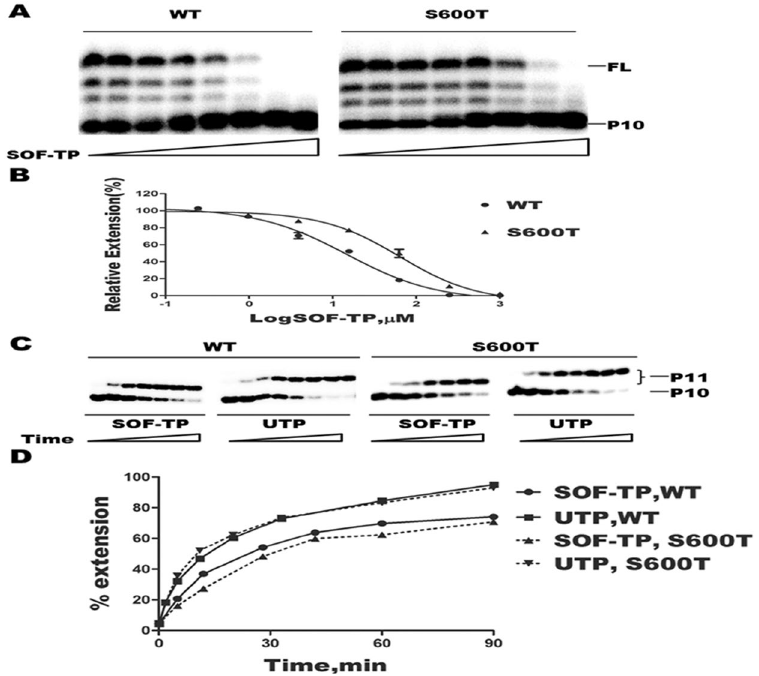
Figure 4. Inhibition of DENV NS5 RdRp activity by SOF-TP and time course of incorporation of SOF-TP or UTP in primer extension assays by DENV WT NS5 and the S600T mutant. ( A ) Inhibitory effect was determined by in vitro primer extension assay using purified NS5 protein s and P10/T14 RNA duplex template in RdRp assay buffer in the presence of 0.5 µ M each of NTPs and variable concentrations of SOF-TP. Reaction products were analyzed by denaturing polyacrylamide gel electrophoresis (6% acrylamide, 7 M Urea). P10 and FL indicate the positions of the 5 ′ -end radiolabelled P10 primer and full-length extension products of the primer extension reactions. ( B ) Dose-response curves showing inhibition by SOF-TP of the activity of DENV NS5 WT and the S600T mutant. The IC50 (50% inhibitory concentration) value was defined as the concentration of SOF-TP at which the full-length (FL) products were decreased by 50% relative to the control reaction performed in the absence of SOF-TP, and was calculated by nonlinear regression analysis: IC 50 WT = 14.7 ± 2.5 µ M, IC 50 S600T = 63.8 ± 5.3 µ M. The data represent the means ± standard deviation (SD) of 3 independent experiments. ( C ) The RNA T14 template and 5 ′ -end radiolabeled RNA primer P10 duplex were used to assess the incorporation efficiency of UTP and SOF-TP on RNA synthesis by use of purified recombinant DENV NS5 WT and S600T mutant enzymes in time course primer extension assays over a period of 90 min. Sampling time points for UTP (min): 0.2, 2, 5, 10, 20, 30, 60, 90; SOF-TP (min): 0.2, 5, 15, 30, 45, 60, 90.P10 and P11 indicate the positions of the unextended and extended primers, respectively. ( D )